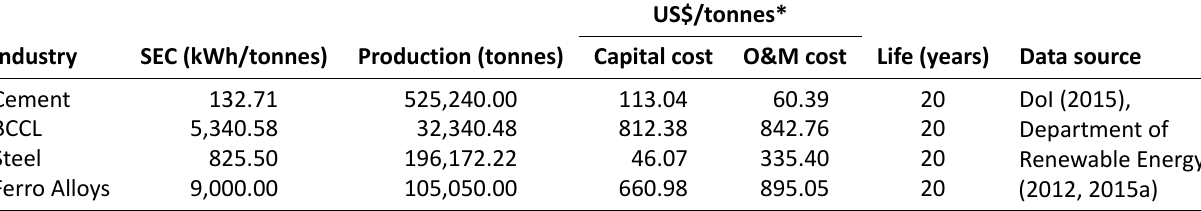
Table A11. Industry sector techno-economic